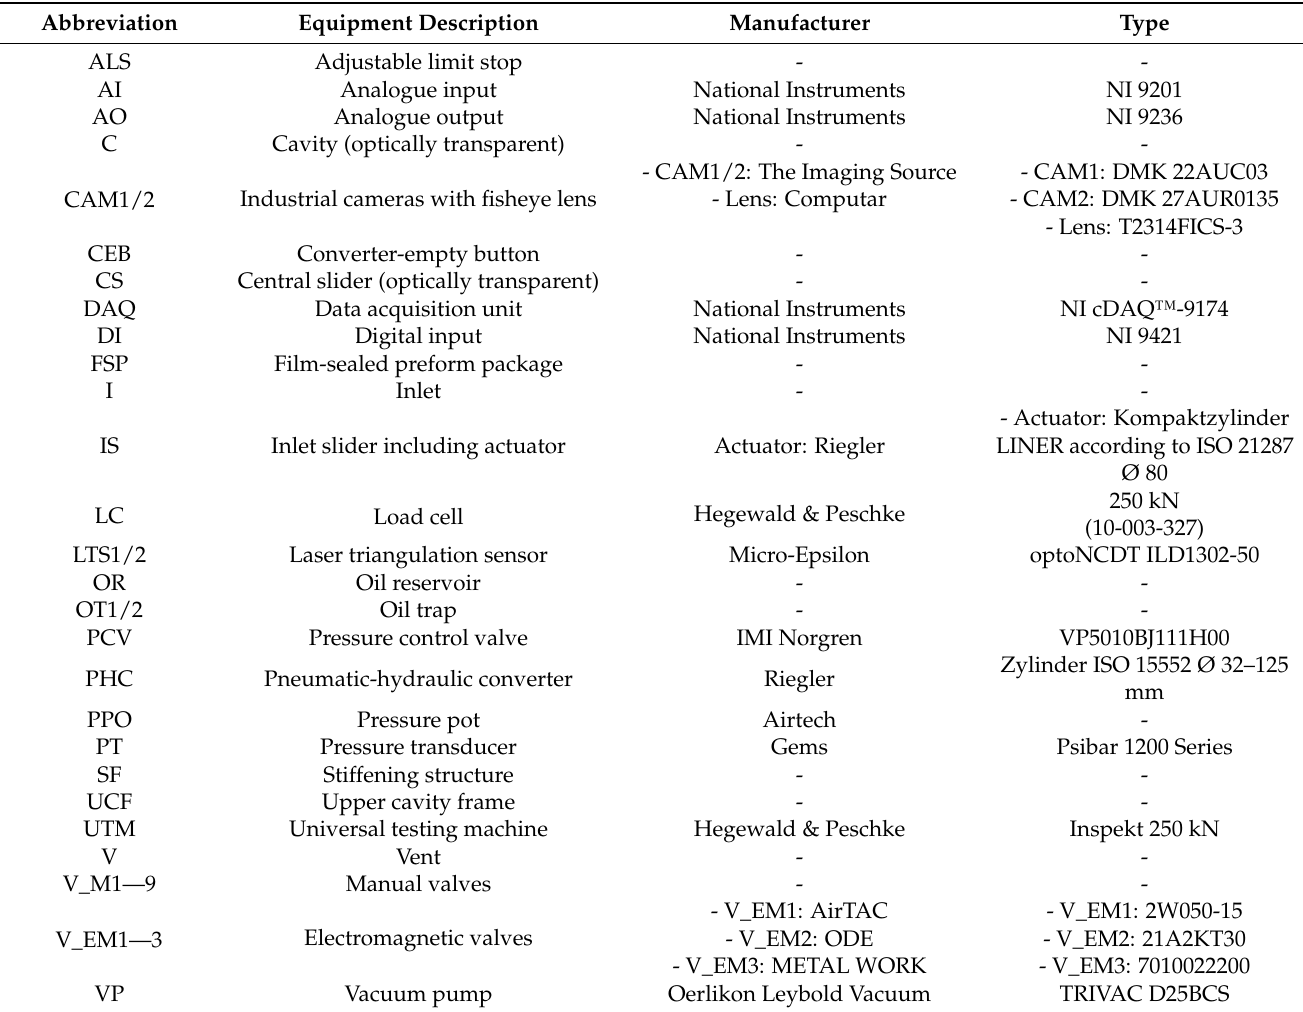
Table A1. List of abbreviations and further details on flow visualization setup of Figure